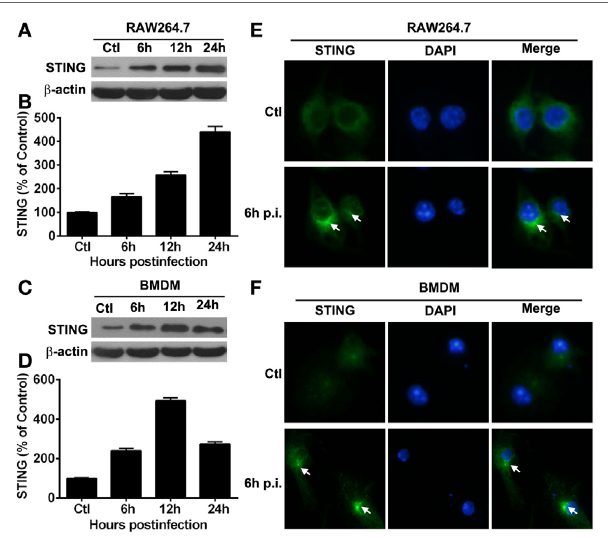
FigUre 4 | The expression of stimulator of interferon genes (STING) in vitro macrophages. (a–D) STING expression was determined by Western blot in murine macrophage-like RAW264.7 cells (a) and bone marrow-derived macrophages (c) at indicated time points after Pseudomonas aeruginosa (PA) infection. STING protein levels were quantitated by relative integrated density values after normalization to β -actin in murine macrophage-like RAW264.7 cells (B) and bone marrow-derived macrophages (D) Data were representative of three individual experiments. (e,F) STING expression and subcellular distribution (green staining) were measured by immunofluorescent in murine macrophage-like RAW264.7 cells (e) and bone marrow-derived macrophages (F) before and at 6 h after PA infection (white arrows indicate STING form perinuclear puncta, magnification = ×